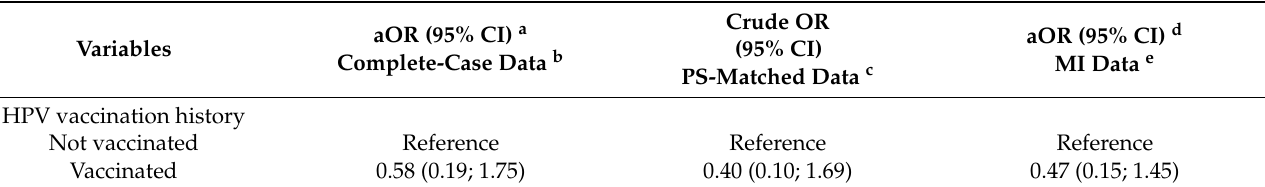
Table 2. Survey-weighted logistic regression models using complete case, propensity score-matched and multiply imputed datasets investigating the association of human papillomavirus vaccination history with HPV-related cancers among U.S. adults aged 20–59 years in the National Health and Nutrition Examination Survey (NHANES),